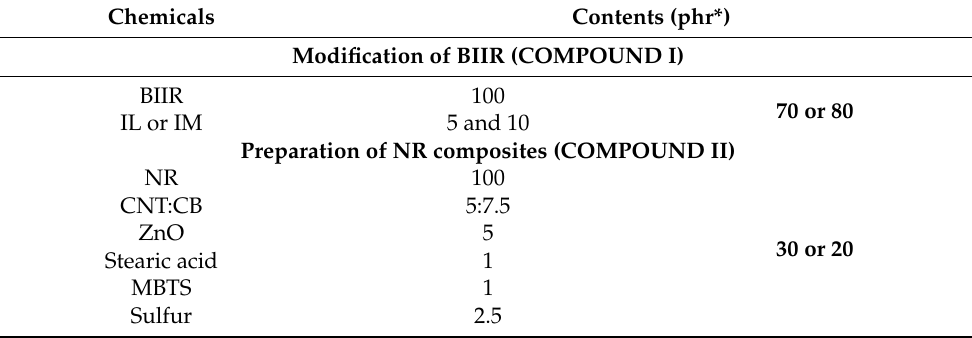
Table 1. Chemicals formulation of pure rubbers and their